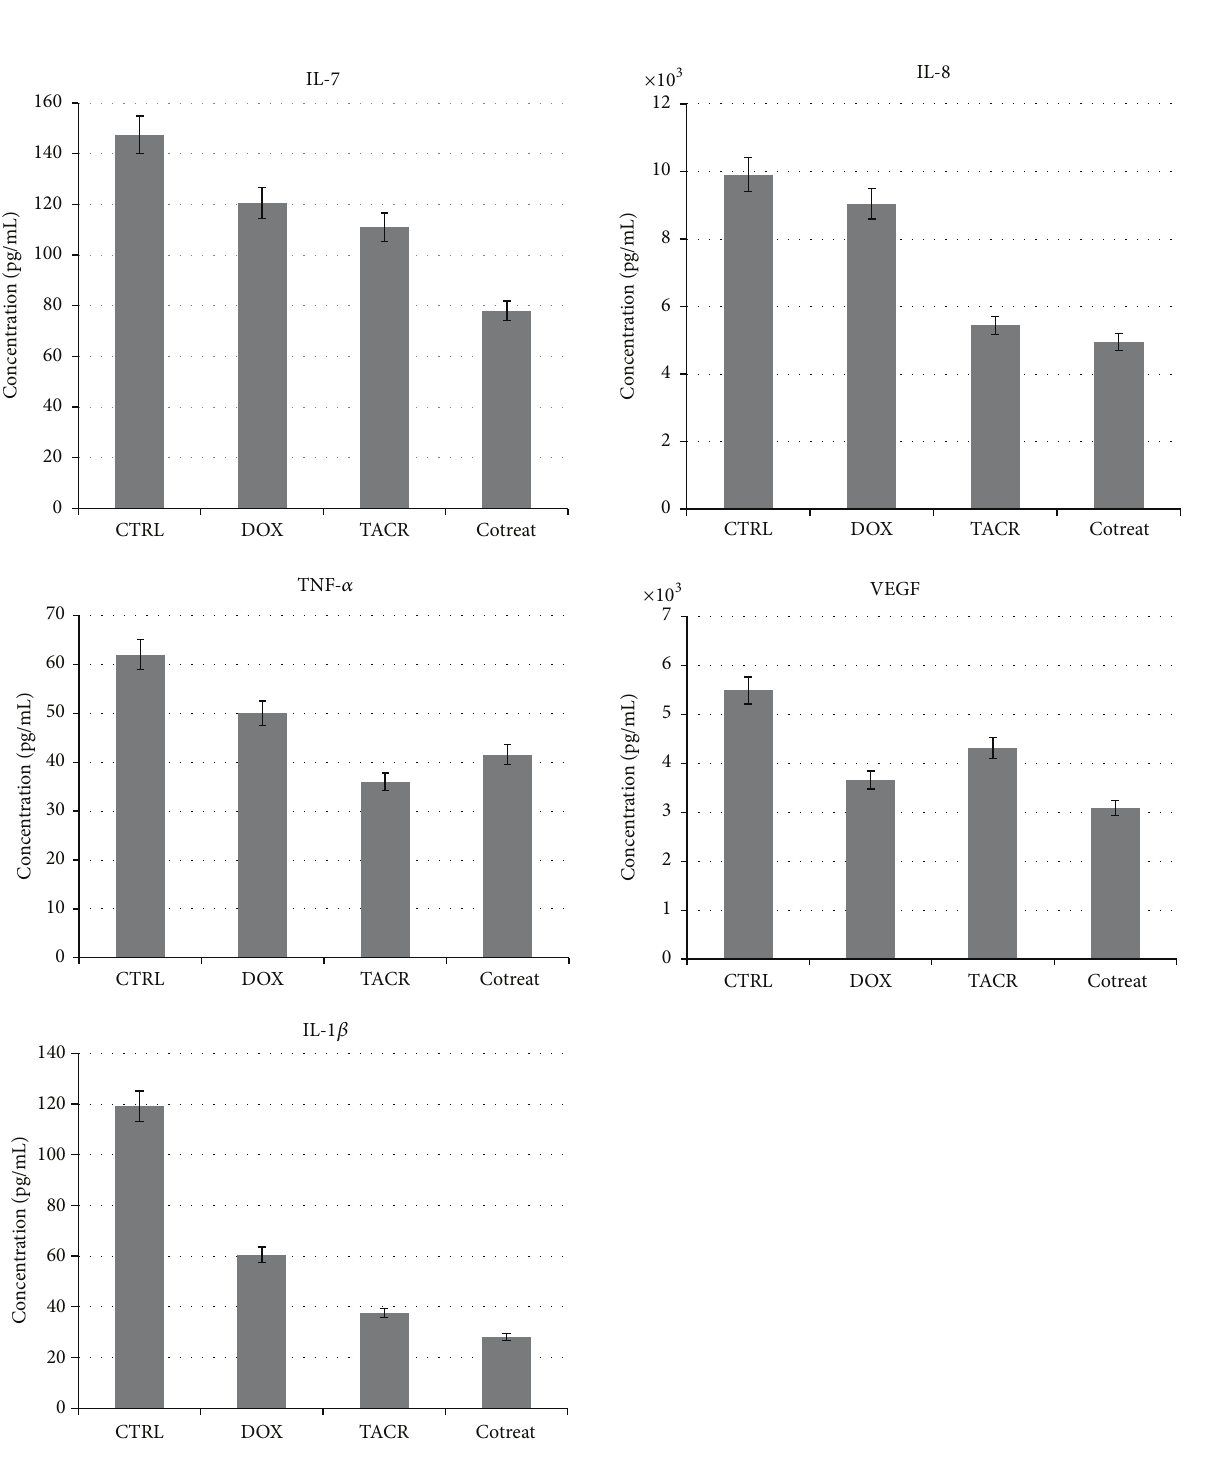
Figure 4: Significant cytokine levels (pg/mL) evaluated in cellular supernatant untreated and after treatment with doxorubicin (0.85 𝜇 M) and tacrolimus (0.052 𝜇 M) and cotreatment (0.42 𝜇 M dox plus 0.026 𝜇 M